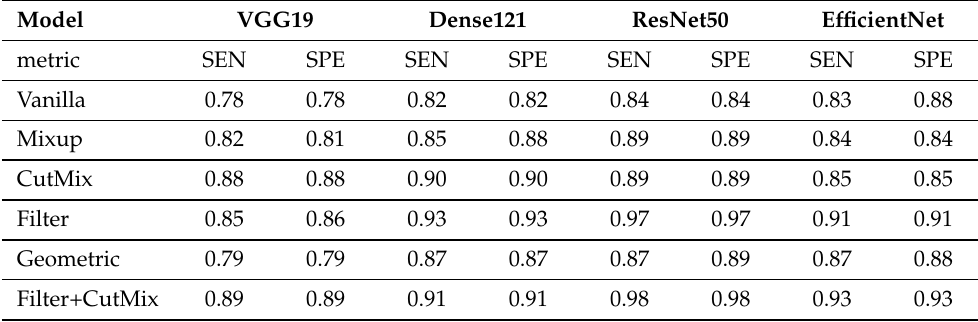
Table 10. SEN and SEP of Histopathology according to Data Augmentation Techniques.